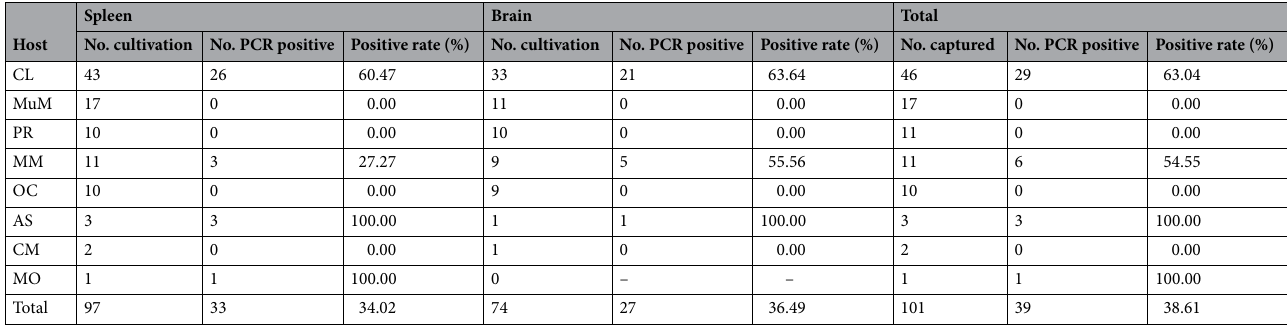
Table 1. Positive rate of Bartonella infection in different tissues of small mammals. CL, Cricetulus longicaudatus ; MuM, Mus musculus ; PR, Phodopus roborovskii ; MM, Meriones meridianus ; OC, Ochotona